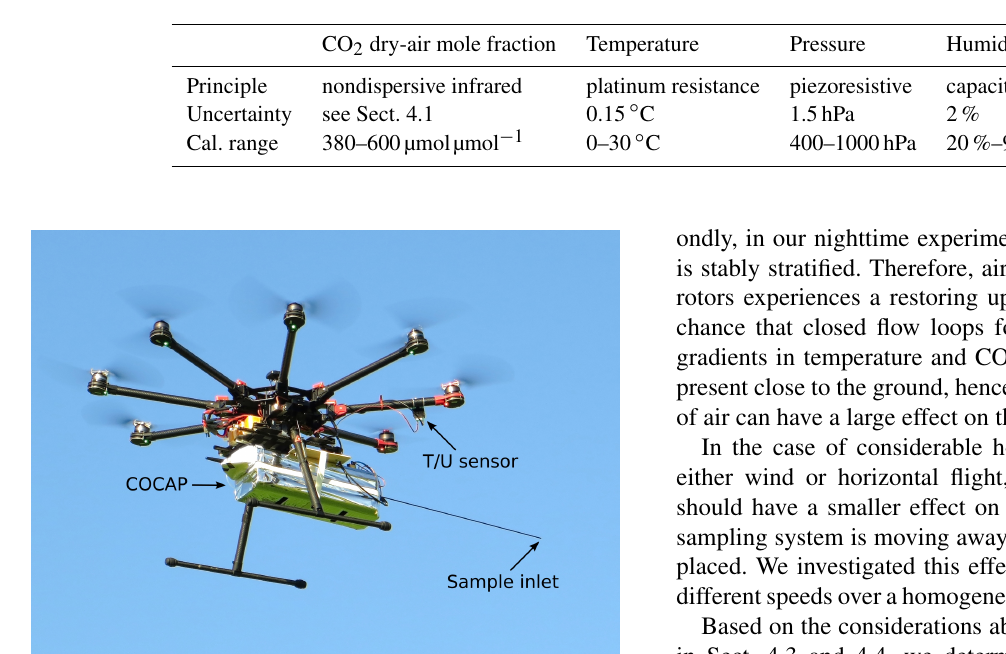
Table 1. Measurement principles, uncertainties and calibration range of the airborne sensors.